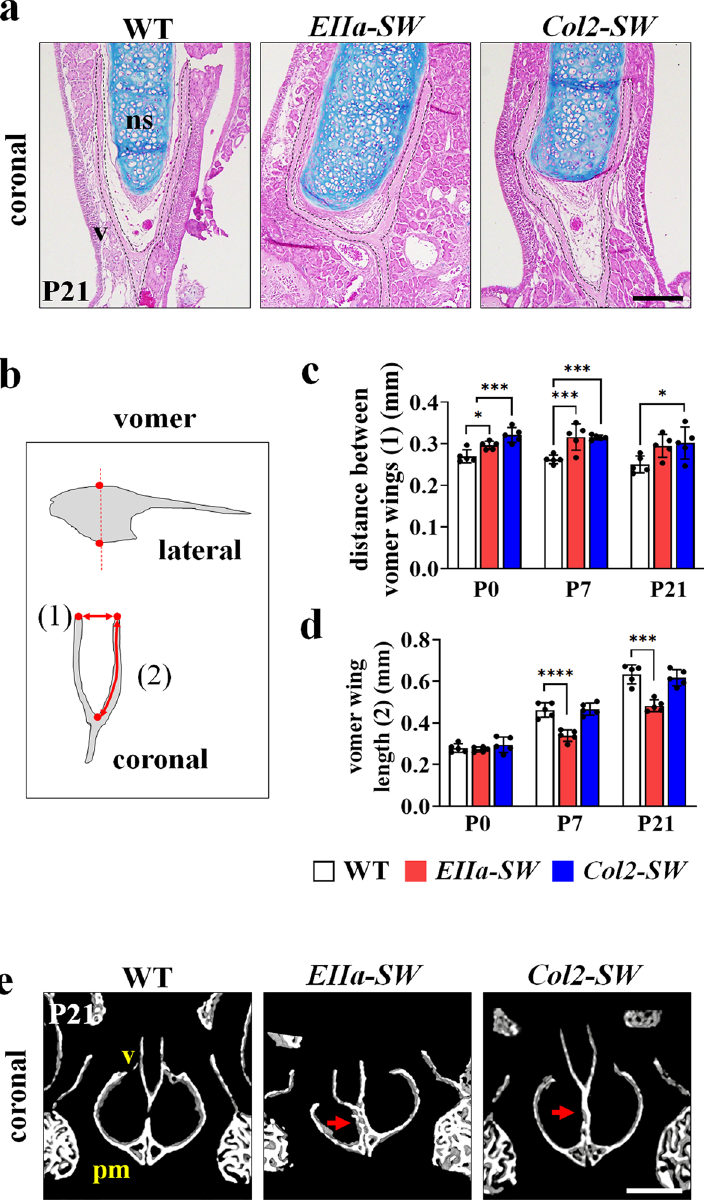
vomer. Scale bar: 200 µm. ( b ) Schematic image of the vomer for linear measurements. The measurements were conducted in the coronal plane of 3D reconstructed images, at the highest and the lowest points on the vomer are seen (red dotted line). The distance between the two vomer wings ( c ) (distance (1) in Fig. 3b) and the length of the vomer wings ( d ) (length (2) in Fig. 3b) were measured. The lengths of the two wings were averaged (n = 5). ( e ) Micro-CT images of the vomer and premaxilla bone in the coronal plane. The red arrows indicate the fusion between the vomer (v) and the premaxilla bone (pm). Scale bar: 0.5 mm. Values are presented as means ± standard deviations. * p ≤ 0.0332, ** p ≤ 0.0021, *** p ≤ 0.0002, **** p ≤